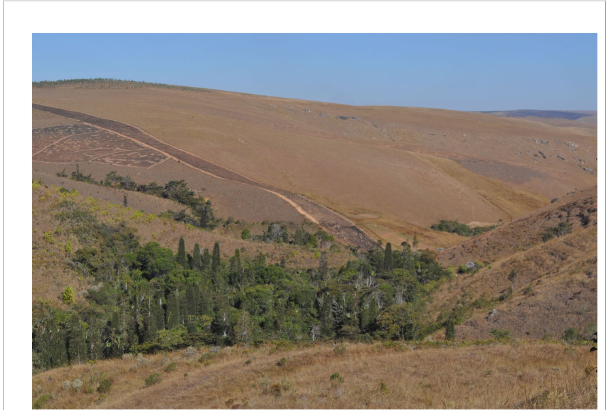
FIGURE 1 Active forest protection from grassland fi res in Madagascar. The parallel strips have been cleared to make a fi rebreak. Fires are suppressed completely on the forest side of the fi rebreak. Australian acacias (light green) have been planted on the slope above the forest. (Photo: W. J.